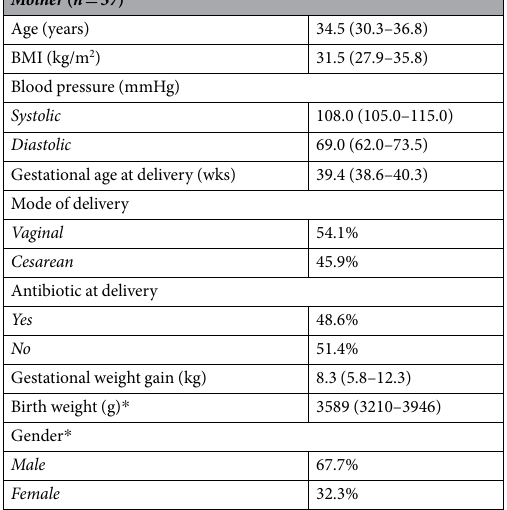
Table 1. Maternal clinical characteristics. Clinical characteristics of mother-baby dyads. All data is presented as median with 25–75 th interquartile range. * Data available from only 31